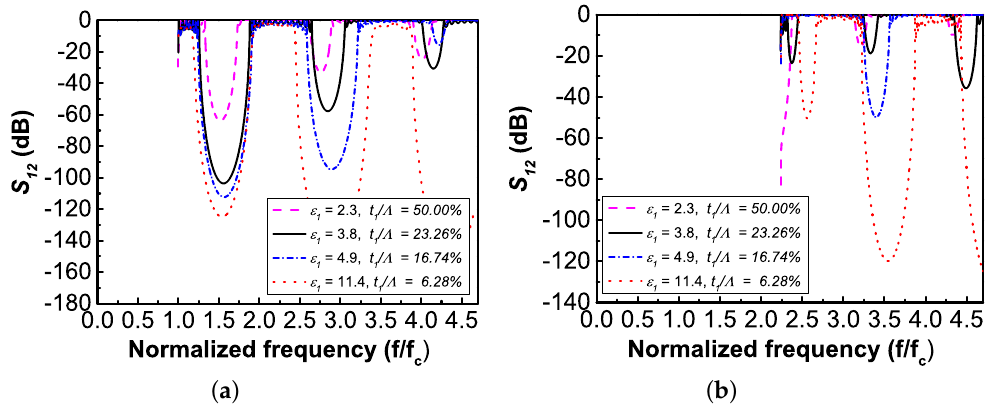
Figure 3. Calculated transmittance, S 12 (dB), of the quasi-1D PCs with 15 double-layer stacks enclosed in the rectangular waveguide for ( a ) TE 10 and ( b ) TM 11 modes of light propagation. The dielectric constants used are ε 1 = 2.3, 3.8, 4.9, and 11.4 and ε 2 = 1, and the corresponding filling ratios are t 1 / Λ = 50.00%, 23.26%, 16.74%, and 6.28% in the four cases. The frequency axes are normalized to